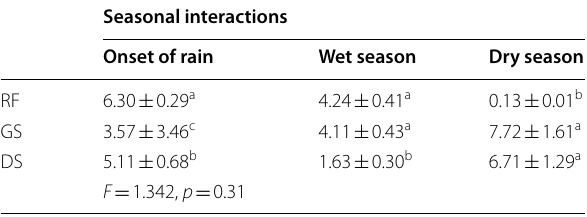
RF rainforest; GS Guinea savannah; DS derived savannah abc Means ( standard deviation) of mean level of MDA in the same column for ± each of the seasonal periods having similar superscripts are not significantly different at p <